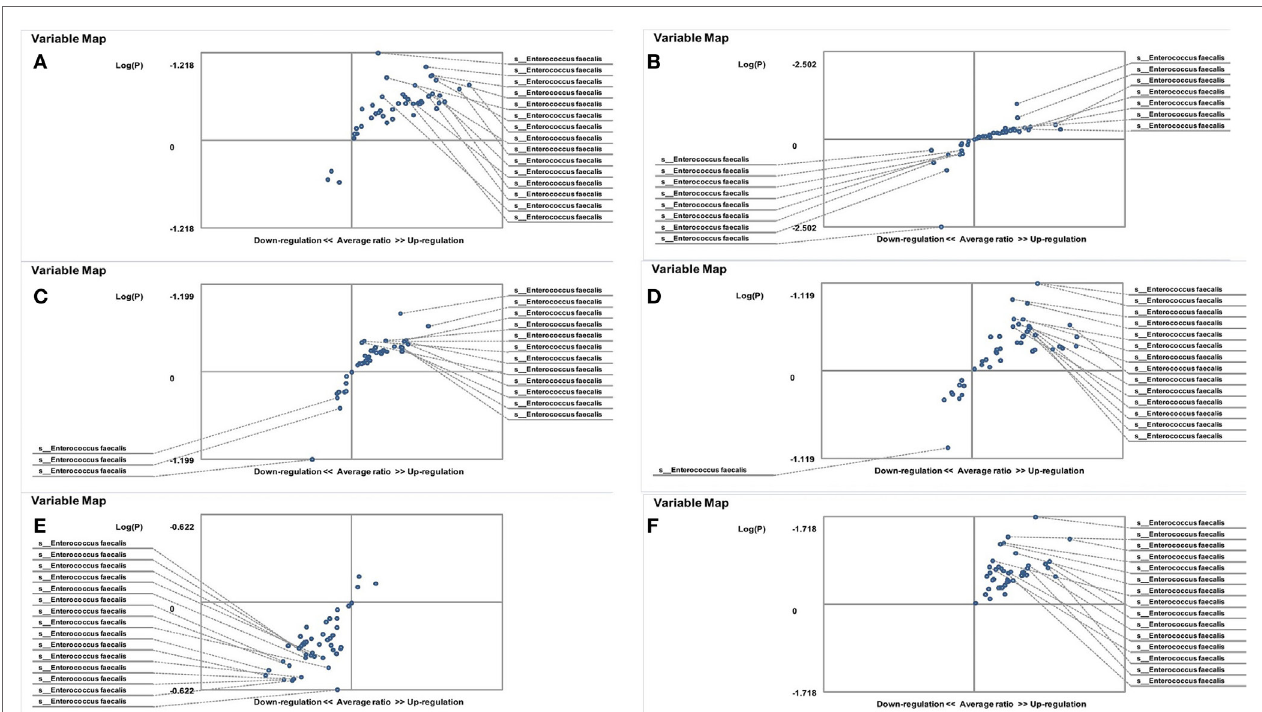
FigUre 4 | Distribution of gut Enterococcus faecalis in familial Mediterranean fever (FMF) carrier women. Contribution of variables to differentiation between two groups [ X axis, average ratio between two groups; Y axis, − Log (P)]. The upper-right and lower-left corner are the most significant. (a) FMF women with Candida albicans below baseline level/healthy women; (b) FMF women with gut C. albicans numbers above baseline level/healthy women; (c) FMF women with C. albicans below baseline level after probiotic therapy/healthy women; (D) FMF women with gut C. albicans numbers above baseline level after probiotic therapy/healthy women; (e) FMF women with C. albicans below baseline level after probiotic therapy/FMF women with C. albicans below baseline level before probiotic therapy; (F) FMF women with gut C. albicans numbers above baseline level after probiotic therapy/FMF women with gut C. albicans numbers above baseline level before probiotic